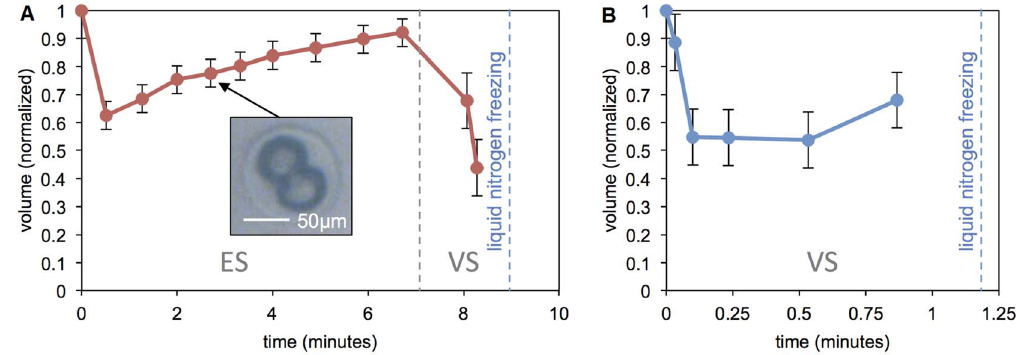
Figure 5. Embryo cell volume monitoring. Mouse embryo cell volume change measured on chip. (A) Vitrified using a two-step human embryo vitrification protocol (Irvine in Figure 6 with the addition of sucrose in the ES stage). (B) Vitrified using a one-step mouse embryo vitrification protocol (CMMR in Figure 6). Snapshots from recorded videos, at instances when the droplet was not moving, were used to measure volume. Volumes were calculated by modeling cells as spheres and were normalized to initial volume (this could result in errors as cells may collapse or flatten instead of shrinking symmetrically [32]. The initial volume dip in the human protocol matches the volume dip over the mouse protocol. For this experiment of volume measurement, 2-cell embryos were used to simplify image analysis. Error bars in (B) are relatively large because for this vitrification protocol, droplets are required to move quickly, which did not leave sufficient time to switch to higher microscope magnification for imaging on our digital microfluidic platform.